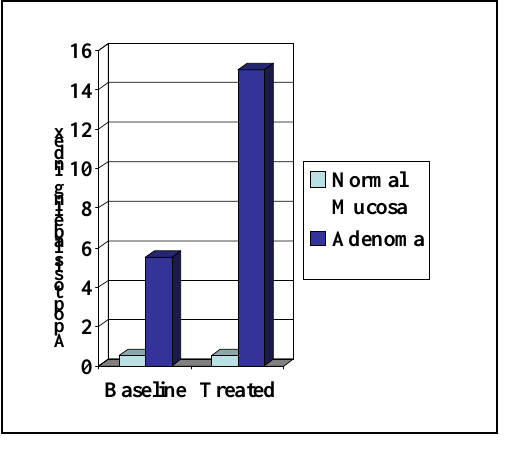
Figure 3. Apoptosis induction by sulindac sulfone in FAP